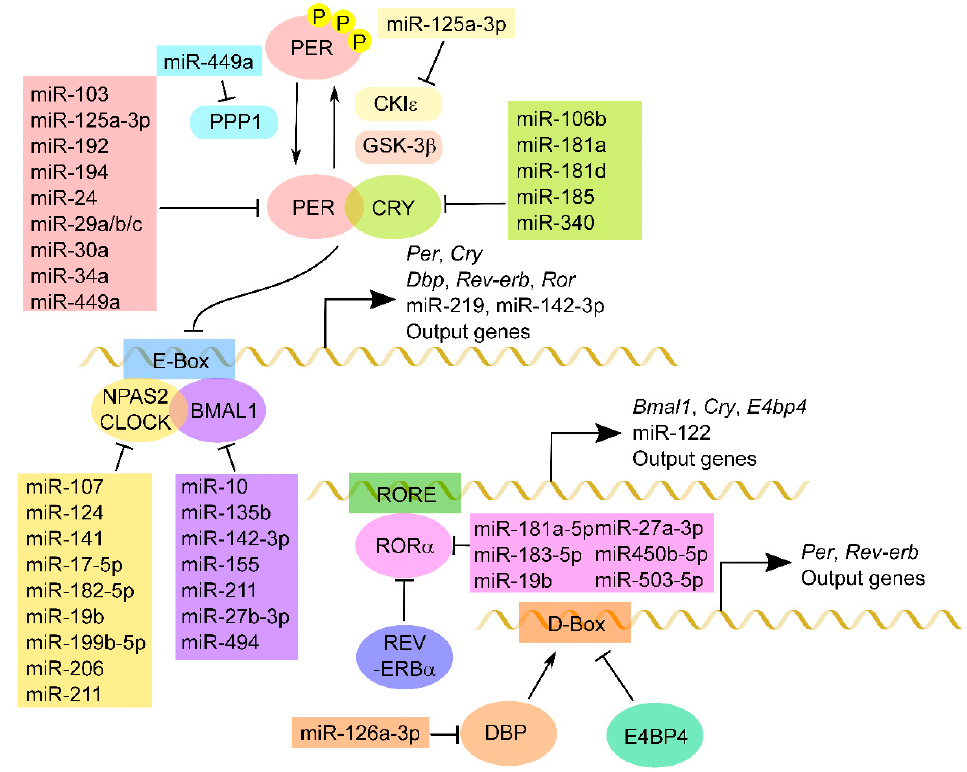
Figure 1. MiRNA regulation of core clock components. A schematic of a molecular circadian system composed of core clock genes is shown. The transcription factors CLOCK:BMAL1 bind to target E-Box and activate the clock genes Per , Cry , Dbp , Rev-erb and Ror , as well as clock-controlled genes,